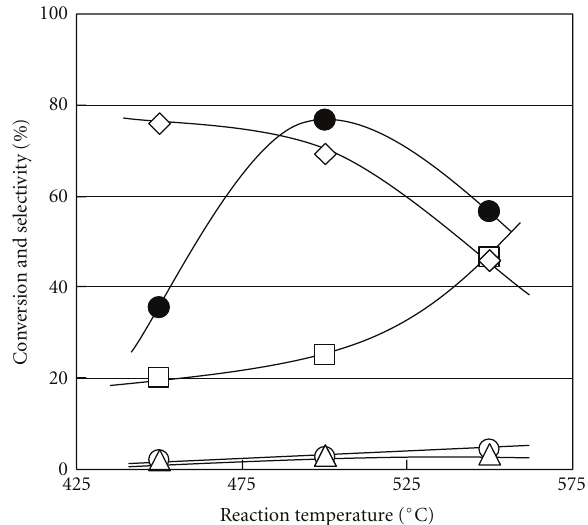
Figure 9: Ga 2p XPS spectra of ns Al 2 O 3 /GaAlMFI zeolite catalyst.